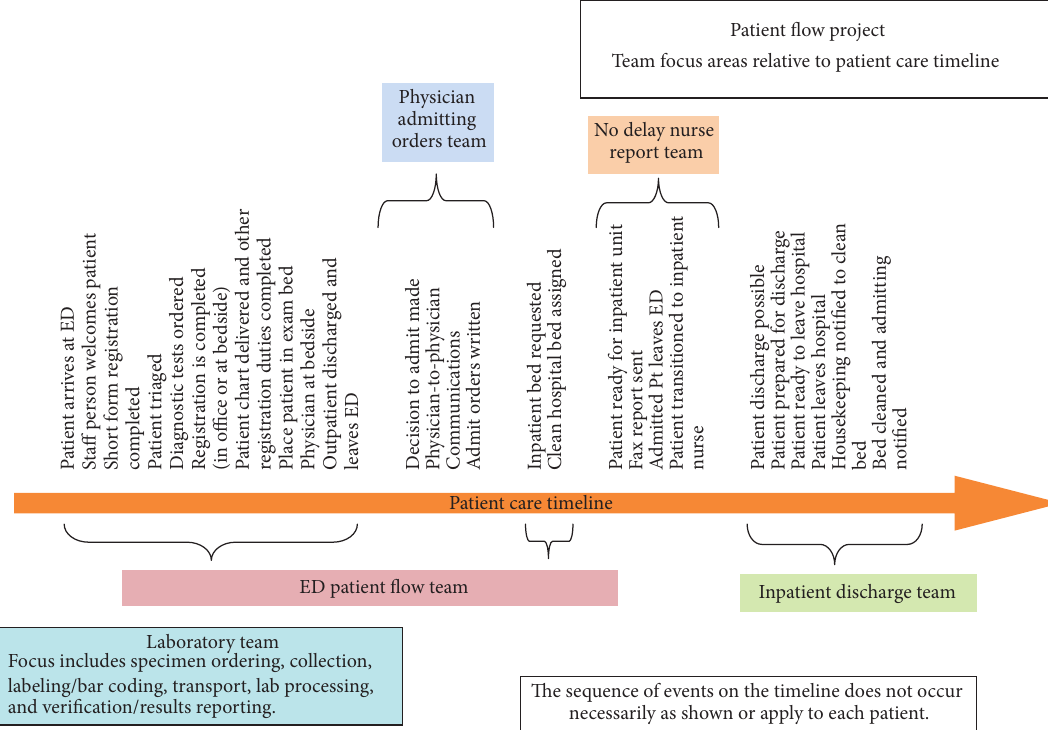
Figure 1: Patient flow